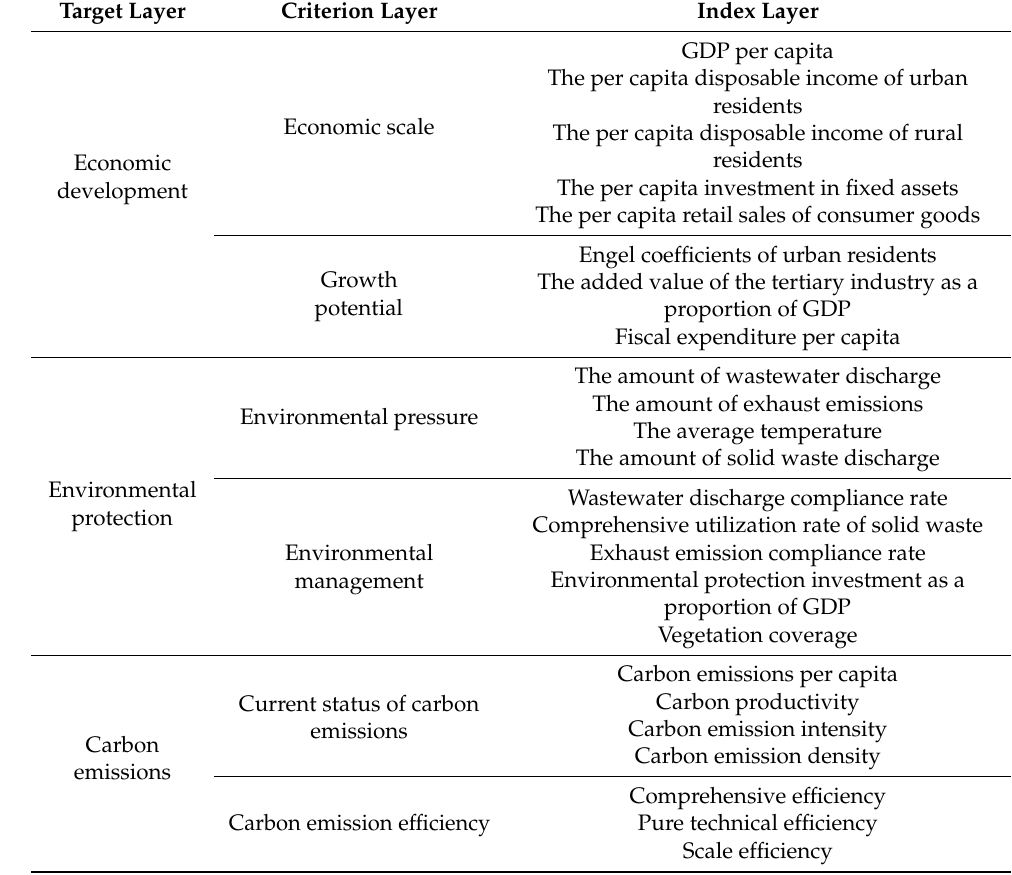
Table 2. The assessment index system of the coordination degree in regard to carbon emissions, economic development, and environmental